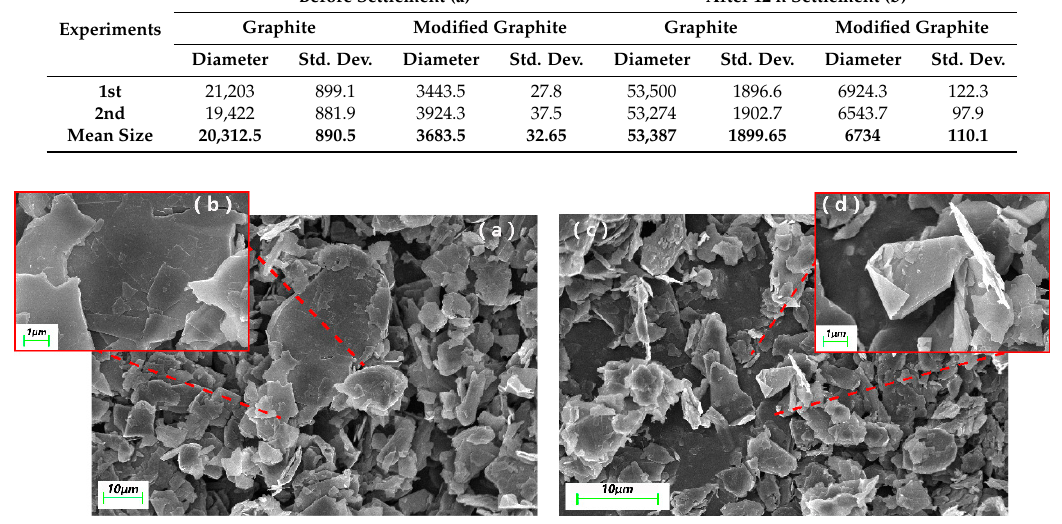
Figure 3. Scanning electron microscope (SEM) images of pristine graphite ( a ) with magnification at 1 µm ( b ) and modified graphite ( c ) with magnification at 1 µm ( d ).